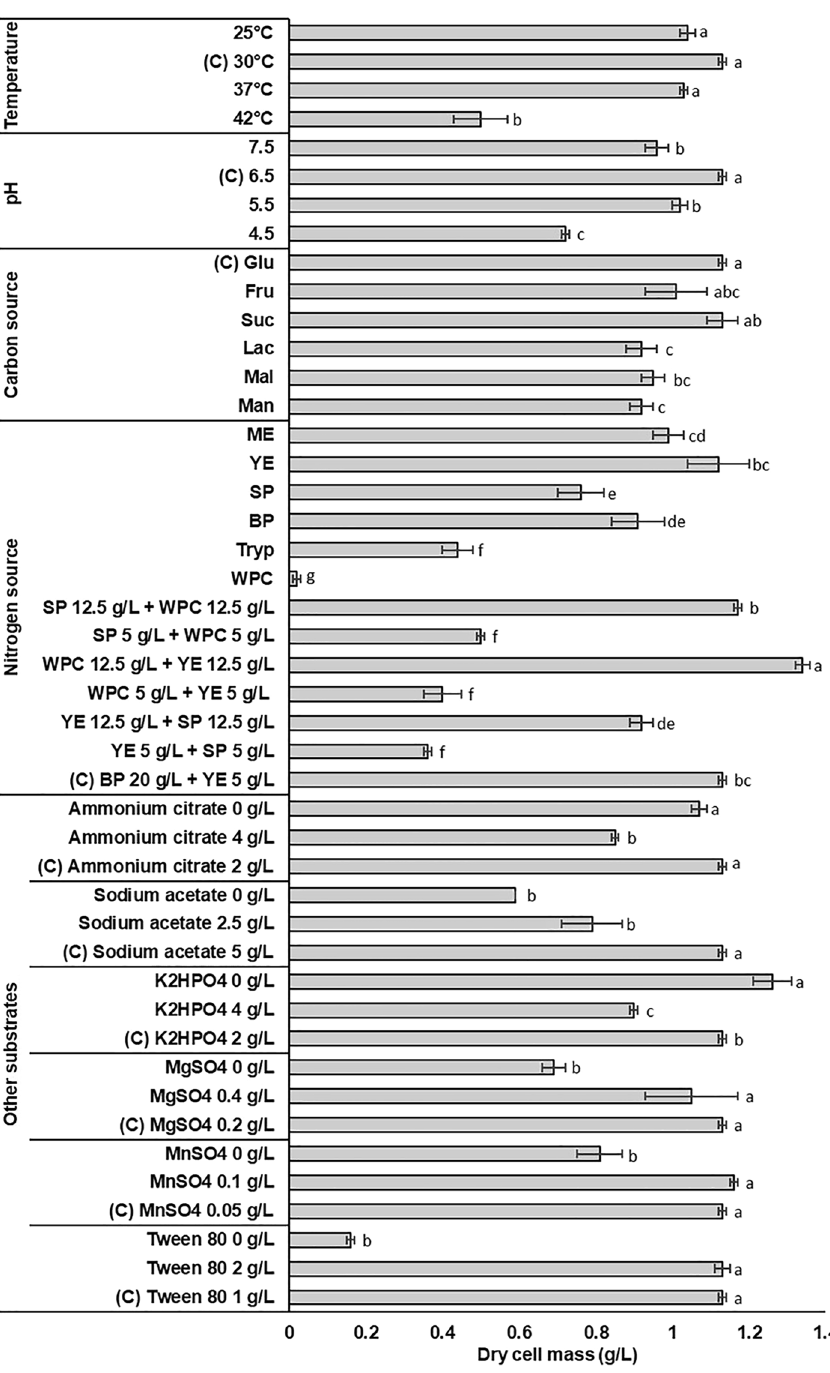
Figure 1. Effects of different incubation temperatures, initial pH, carbon sources, organic nitrogen sources, salts and Tween 80 on the biomass production of L. sakei ACU-2. Results are the mean values of the triplicates and the error bars indicate the standard deviation. Different letters within groups represent significant differences ( p < 0.05, Tukey test). (C)